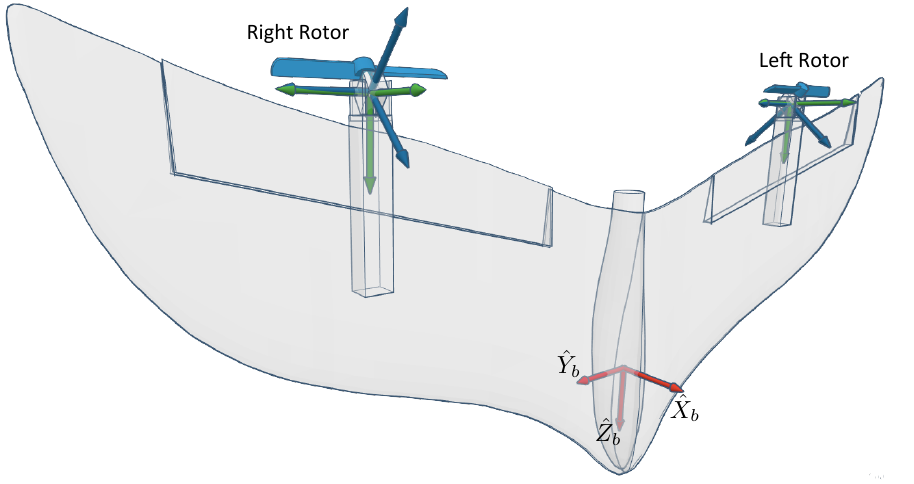
Figure 2. Local axis in the 3D graphical model of the V-Skye